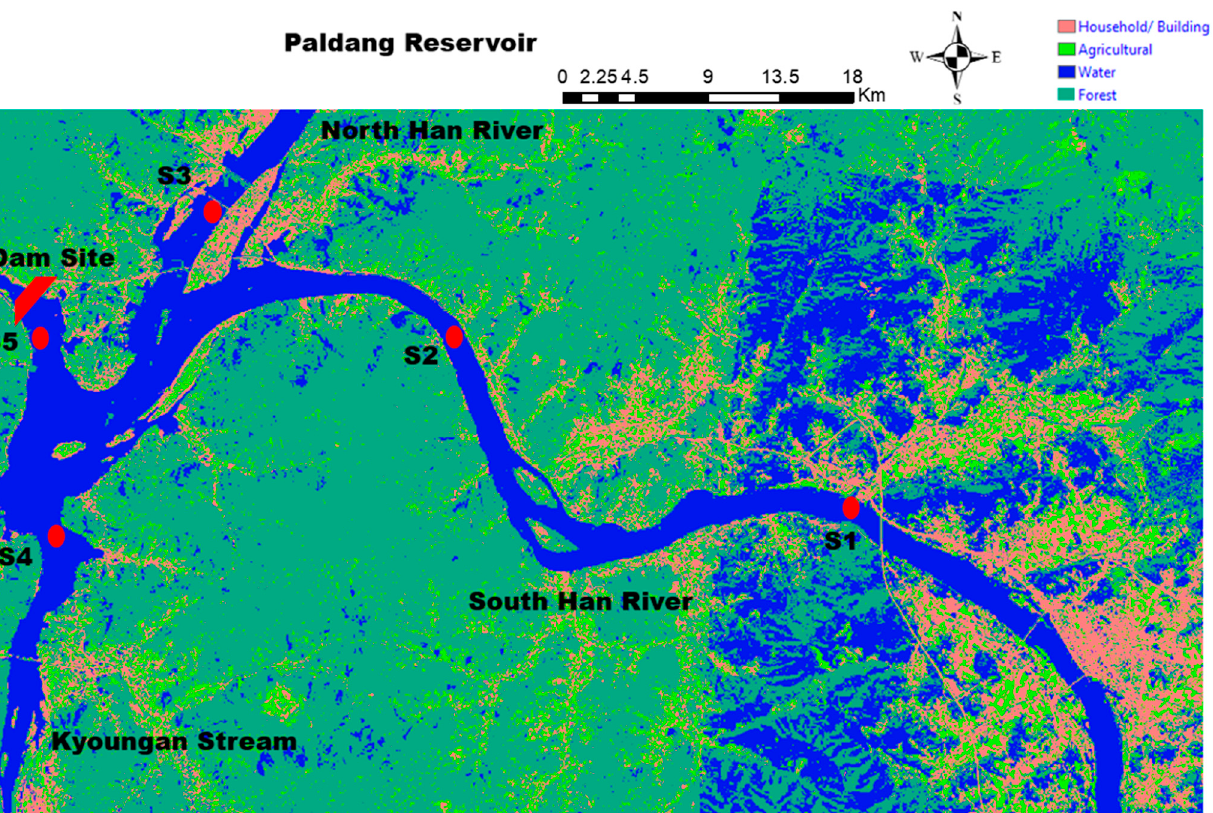
Figure 1. The map showing the sampling sites of Paldang Reservoir.